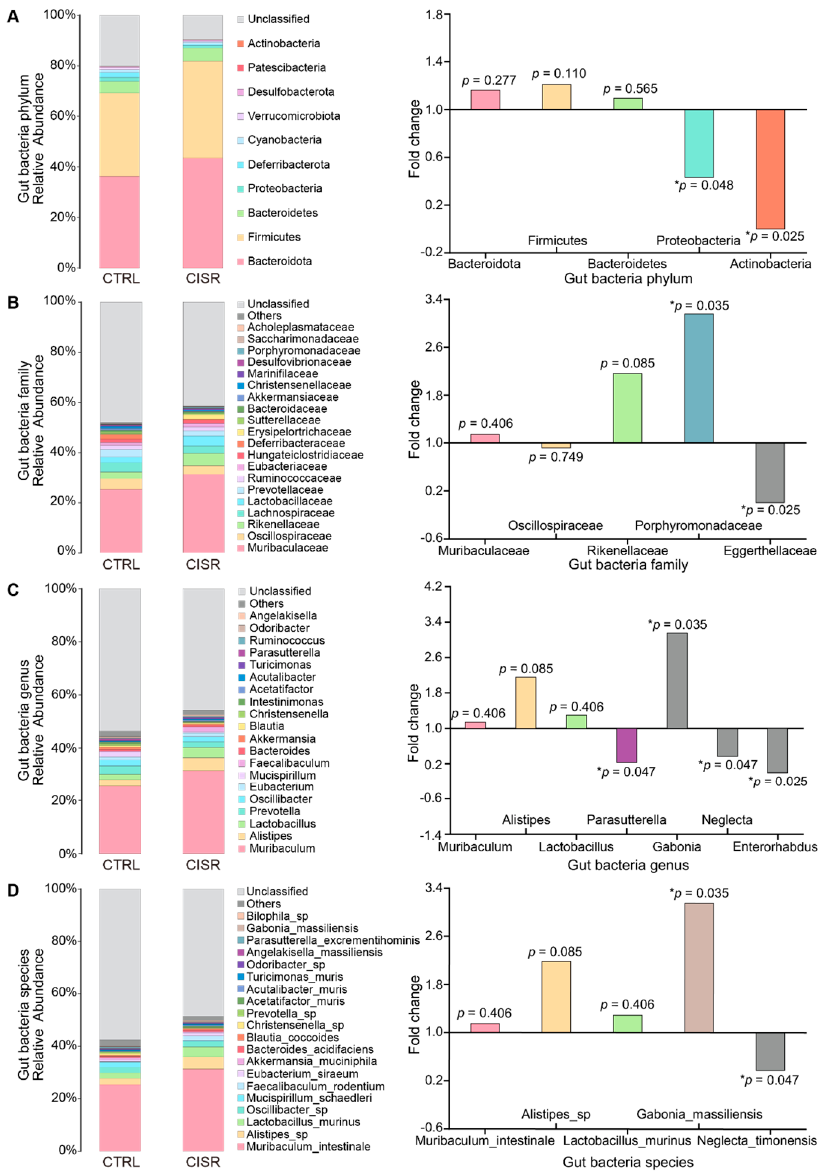
Figure 3. Quantitative visualization of microbial composition and the significantly altered microflora. Species abundance distribution map of the CTRL and CISR groups at the ( A ) phylum, ( B ) family, ( C ) genus, and ( D ) species levels. Wilcoxon rank − sum test of variance between groups showed altered gut microbiota composition at these levels. The fold change (FC) values and the up − down regulation of the flora with greater abundance or significant differences were shown in the right panels. The values were presented as the mean ± SEM. Significant differences were indicated by asterisks (* p < 0.05).